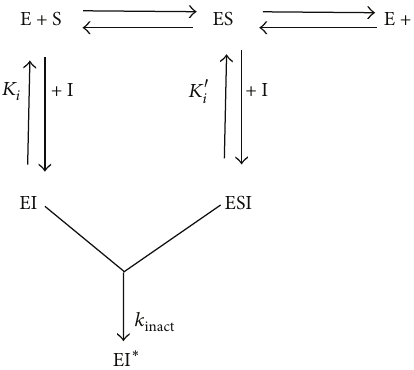
Figure 6: Pathways for irreversible inhibition [11]. 𝐾 is a measure i is of the binding affinity for the inactivator for the free enzyme. 𝐾 󸀠 i a measure of the binding affinity for the inactivator for the enzyme- describes the rate at which inhibitor- substrate complex and 𝑘 inact enzyme complex is irreversibly transformed into EI ∗